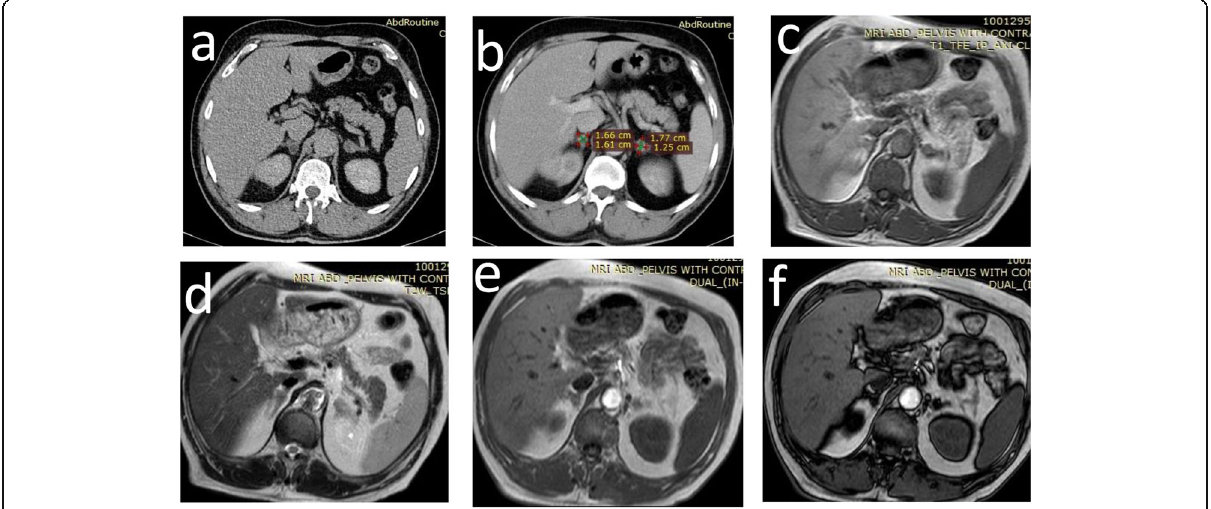
Fig. 4 A 60-year-old male patient complaining of progressive hematuria was diagnosed by cystoscopy and histopathology to have bladder carcinoma. a Precontrast and b Post-contrast MDCT abdomen axial images showing bilateral hypodense suprarenal nodules measuring 1.6 cm on the right side and 1.7 cm on the left one along their maximum diameter. RPW = 63% on both sides. MRI suprarenal protocol ( c ) axial T1 ( d ) axial T2 showing bilateral suprarenal nodules of intermediate signal in both sequences. e , f in phase and out of phase images showing differential and remarkable loss of signal in the opposed phase images denoting intracytoplasmic fat, along with their small size favoring the diagnosis of lipid- rich adenomas. Diagnosis was further proven by PET CT showing no suprarenal